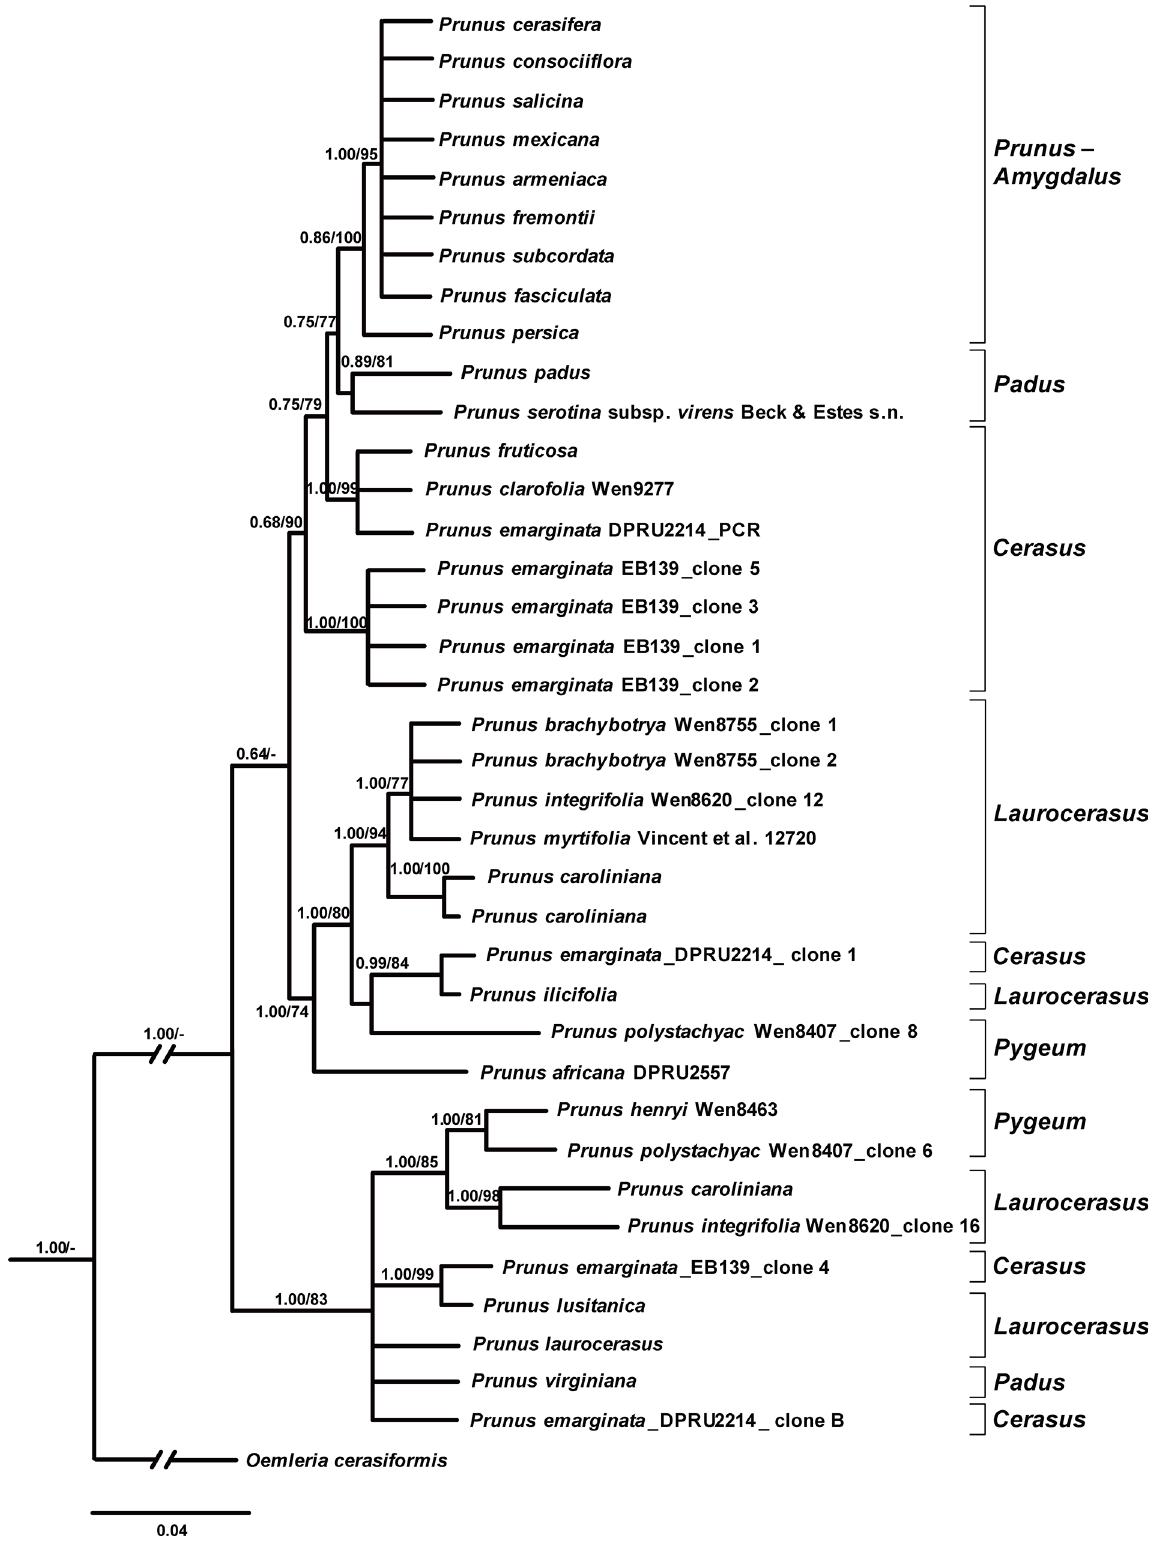
Fig 6. Bayesian tree inferred from the s6pdh DNA sequences of Prunus . Bayesian posterior probabilities (left) ( (cid:1) 0.95) and likelihood bootstrap (right) values ( (cid:1) 50%) are given above branches. Dashes represent bootstrap (cid:3) 50%. doi:10.1371/journal.pone.0157123.g006 PLOS ONE | DOI:10.1371/journal.pone.0157123 June 13,